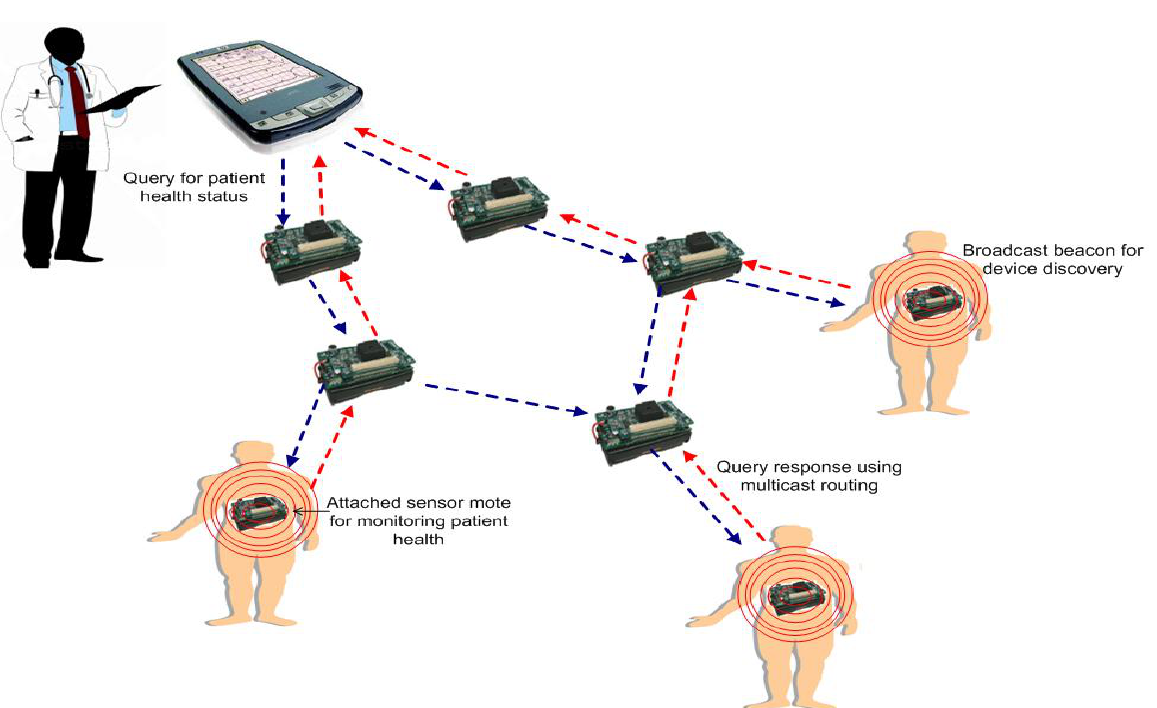
Figure 1. Overview of CodeBlue architecture and